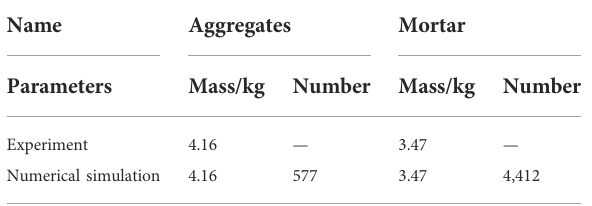
TABLE2Comparisontableofexperimentalandsimulatedparameters.